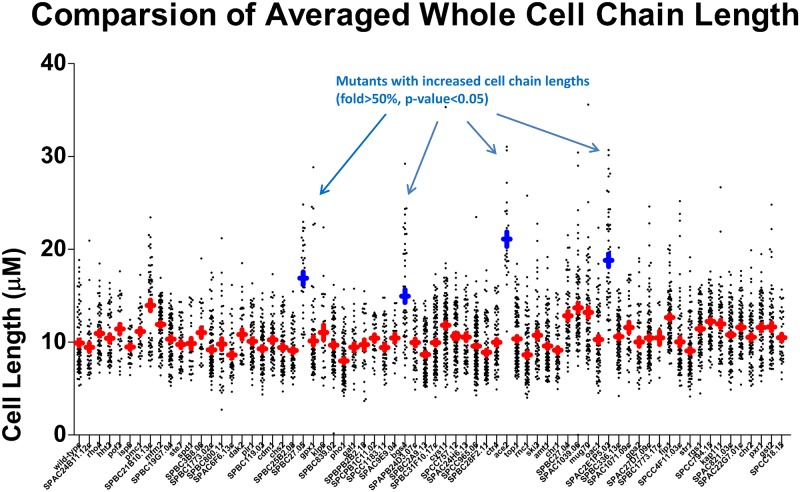
Averaged “whole cell chain” lengths of candidate knock-out strains.The “whole cell length chain” distribution of all the selected 69 candidate knock-out strains. The red points represent the median value of the cell lengths, and the blue points represent the mutants with the significantly increased whole cell chain lengths (fold>1.5, p-value<0.05). The gene name of systemic ID of these strains listed in this figure are (from left to right): wild-type, SPAC24B11.12c, rho4, hht3,pof3, isp6, pmc1, SPBC21B10.13c, mfm2, SPBC19G7.04, ste7, spd1, SPBC3B8.06, SPBC1773.02c, SPBC800.11, SPAC6F6.13c, dak2, plr1, SPBC119.03, cdm1, chs2, SPBC25B2.08, SPBC27.05, gpx1, klp6, SPBC839.02, pho1, gal1, SPBPB2B2.18, SPCPB1C11.02, SPCC1183.11, SPAC9E9.04, bgs4, SPAPB24D3.07c, SPBC2A9.13, SPBC31F10.17c, cys11, SPCC757.12, SPAC24H6.13, SPCC965.06, SPBC28F2.11, ctr4, ace2, top1, rnc1, ski3, amt1, chr1, SPBC27.04, SPAC1039.06, mug70, oac1, SPAC2E1P5.03, SPBC336.13c, SPAC1071.09c, gpa2, SPAC27D7.09c, SPBC1773.17c, fip1, SPCC4F11.03c, str1, rgs1, SPCC794.15, kap111, SPAC821.03c, SPAC22G7.01c, chr2, pxr1, gst2, SPCC18.15.